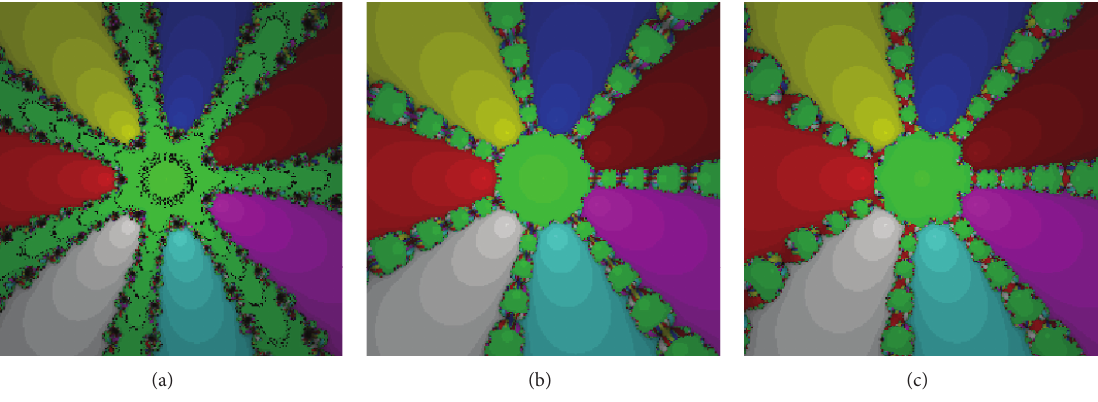
Figure 6: The basins of attraction for CM 2 4 (a), OM 4 (b), and MOM 4 (c) in problem